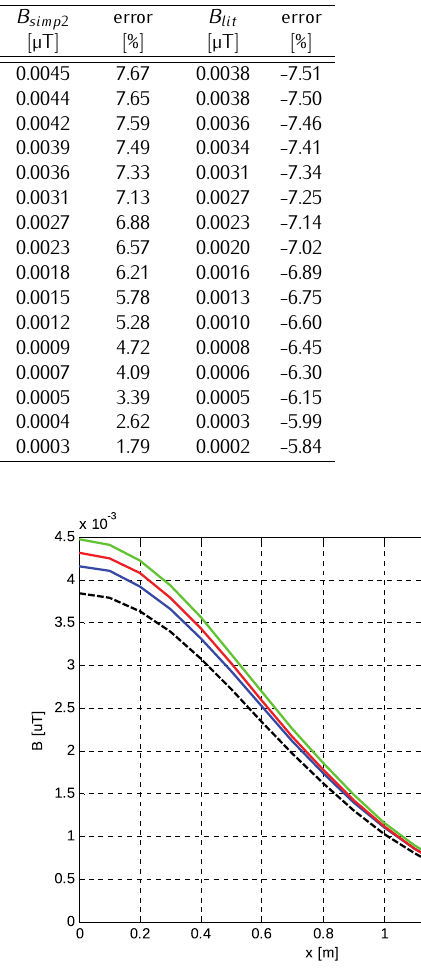
Figure 7. B exact , B simp 1 , B simp 2 , B lit at 1 m height from the ground vs. horizontal distance x from the orthogonal projection of the cable axis on the plane parallel to the ground at the same height for the cable ARE4H1RX 12/20 kV 3 × 120 mm 2 in underground line configuration at a depth of 0.80 m in linear